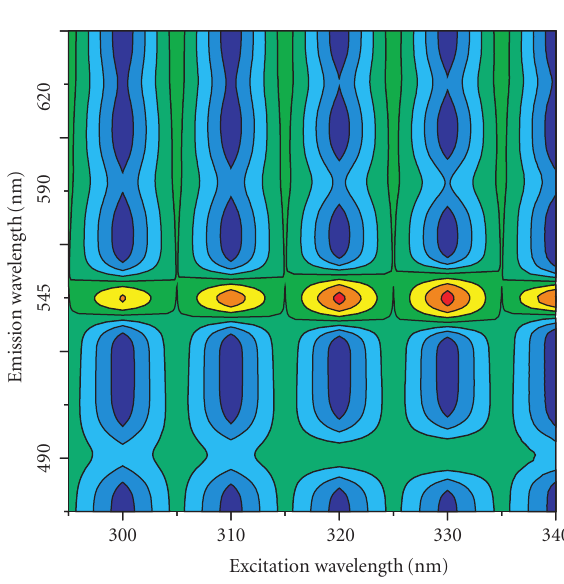
Figure 7: Contour view of the emission spectra of Tb 3 + ion in Tb- (III) complex at di ff erent excitation wavelengths in DMSO.